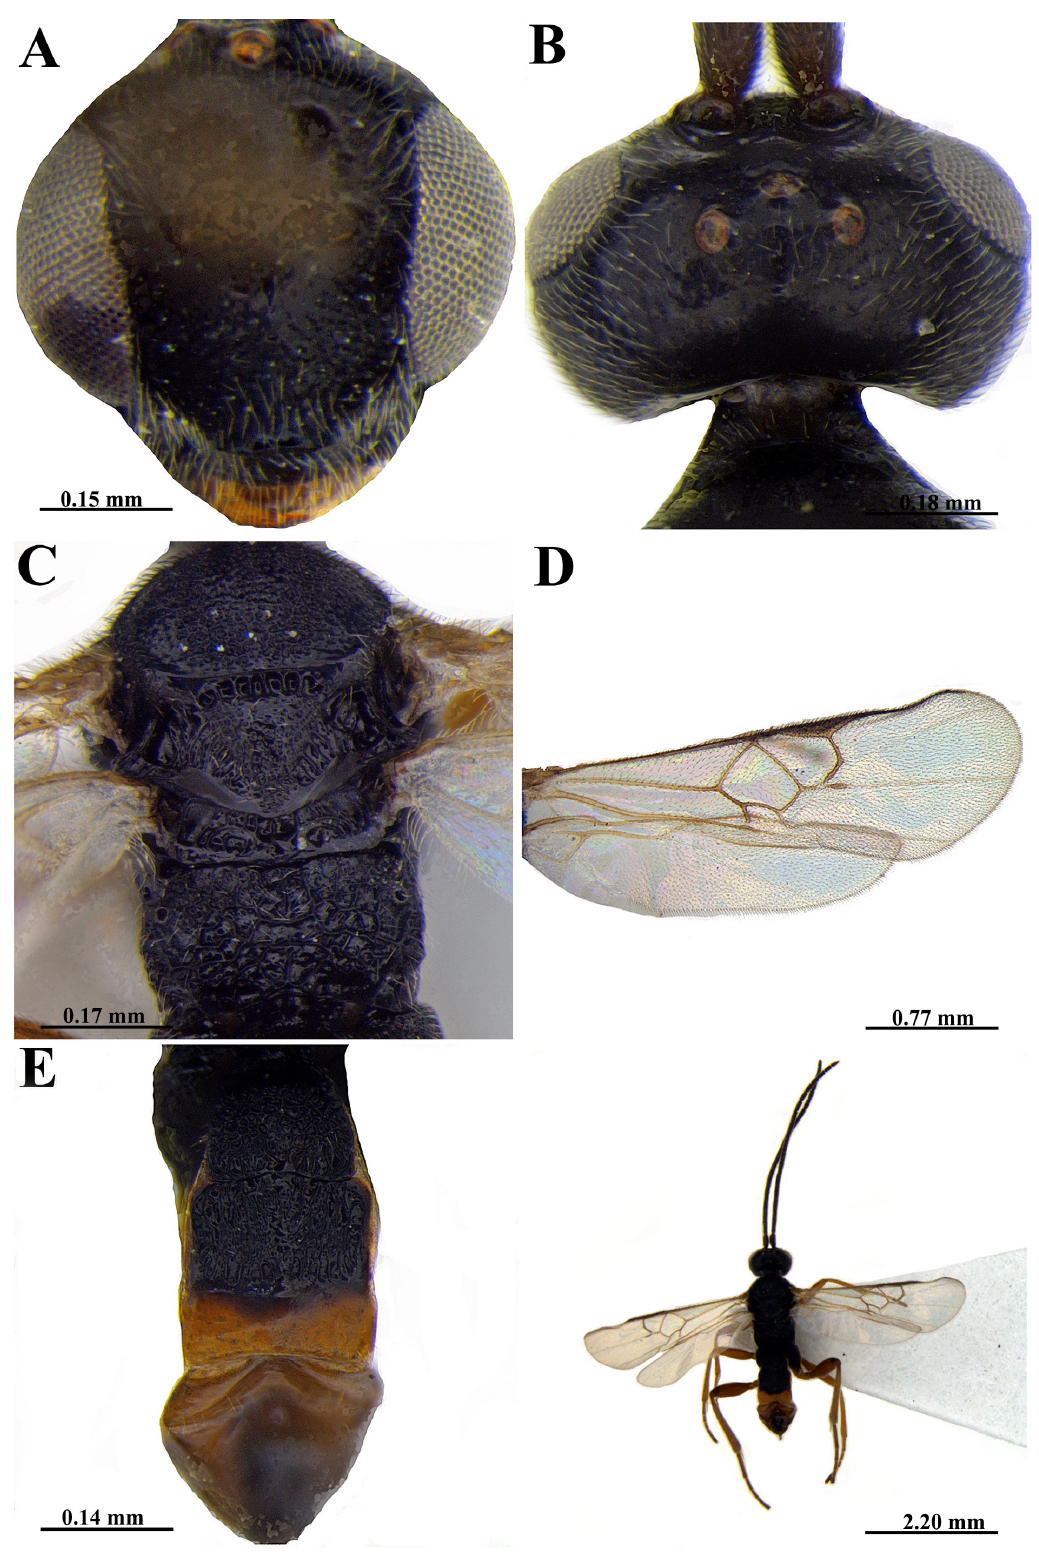
Fig. 1. Cotesia elongata Zargar & Gupta sp. nov., ICAR-NBAIR/NIM/MICROG/COT/22517H. A . Head, frontal view. B . Head, dorsal view. C . Mesosoma, dorsal view. D . Fore wing. E . Metasoma, dorsal view. F . Habitus, dorsal